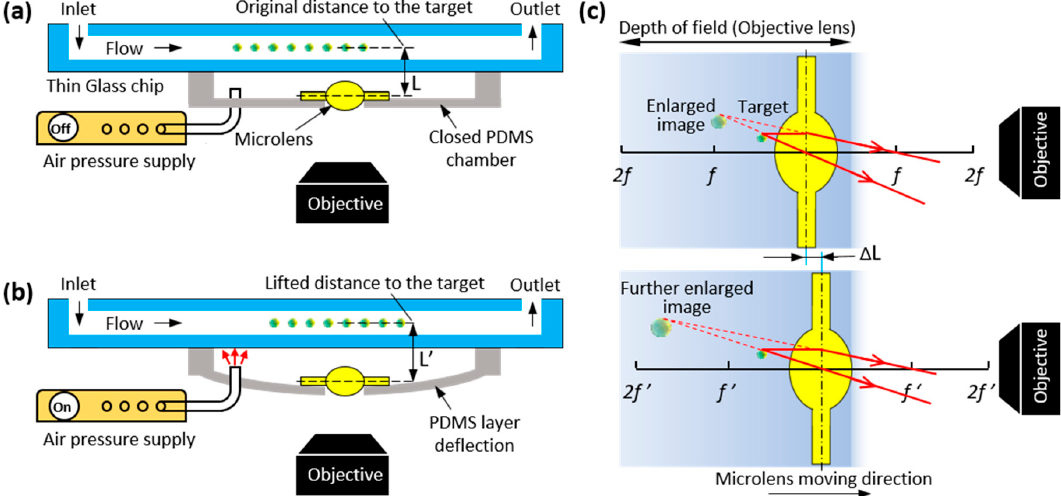
Figure 1. Schematic drawings of the optical observation method and the imaging principle of the system. ( a ) When no external air pressure is applied to the closed Polydimethylsiloxane (PDMS) chamber, the optical system keeps the microlens’ original position and magnification. ( b ) When air pressure is applied, the microlens position is lifted as the chamber is inflated with air. The system’s magnification is changing along with the microlens position altering during the process. ( c ) The imaging principle of this system that achieves various magnifications by changing the microlens position between the objective lens and the target.